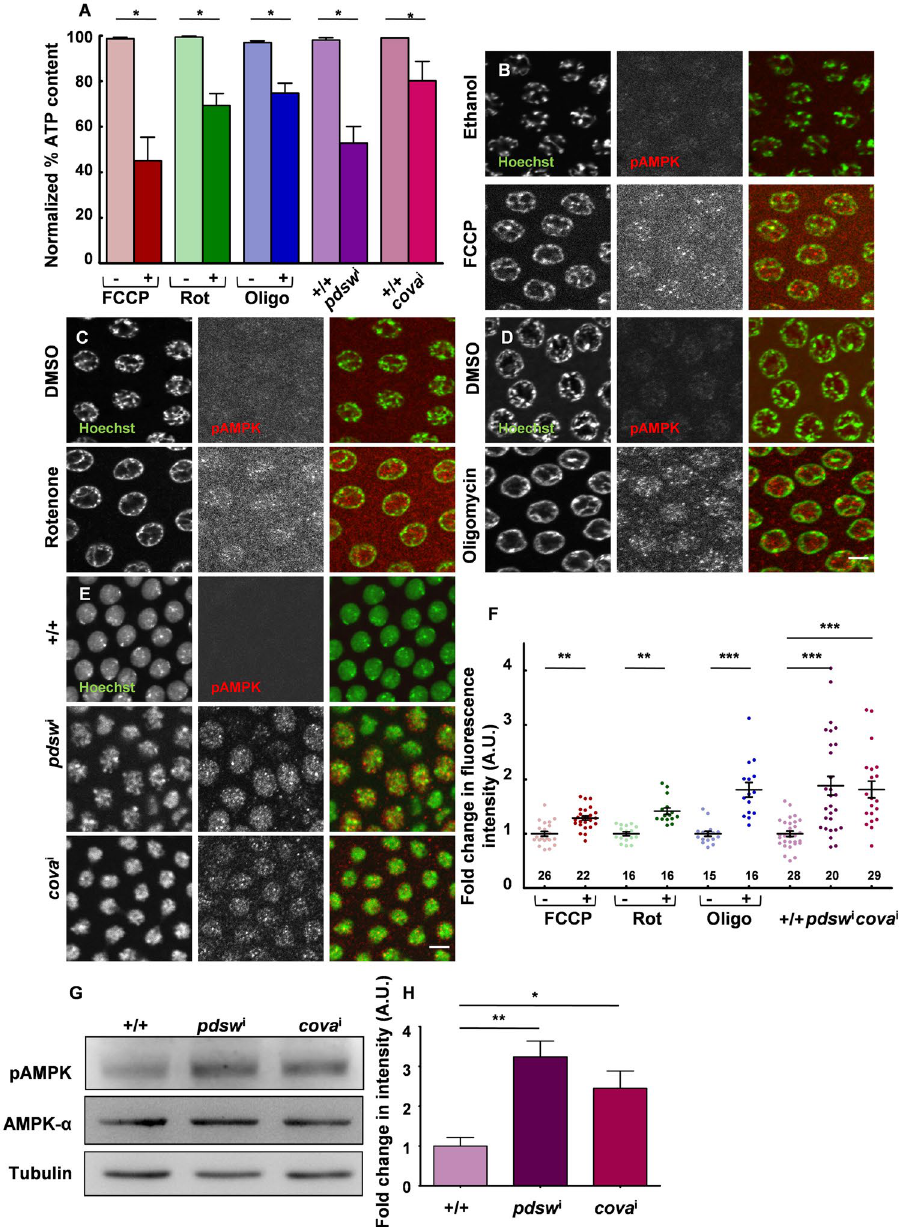
Figure 5. ETC depletion reduces ATP and increases pAMPK in syncytial Drosophila embryos. ( A ) Decrease in ATP due to ETC inhibition. The ATP concentration determined by a luciferase based assay is normalized to amount of protein from embryos in each sample and represented as a percentage of the corresponding control. FCCP (red), Rotenone (green) and Oligomycin (blue) treated embryos and pdsw i (purple) and cova i (pink) mutant embryos show a significant reduction in ATP. ( * P ≤ 0.05, n = 9, N = 3, one tailed Mann–Whitney test). ( B – F ) Genetic and pharmacological inhibition of the ETC shows increased pAMPK in syncytial embryos. Elevated pAMPK (red in merged) signal is seen in FCCP ( B ), Rotenone ( C ) and Oligomycin ( D ) treated embryos compared to respective controls imaged at the same settings. pdsw i and cova i ( E ) show increased pAMPK signal compared to control embryos. Normalized fluorescence intensity of pAMPK in embryos treated with FCCP (red), Rotenone (green) and Oligomycin (blue) and pdsw i (purple) and cova i (pink) compared to their respective controls represented by lighter shades ( F ). Numbers and data points represent embryos analysed. ( ** P ≤ 0.01; *** P ≤ 0.001, two tailed Mann-Whitney test.). n = 22, 26 embryos for control and FCCP; 16,16 embryos for control and Rotenone; 16, 15 embryos for control and Oligomycin; 29, 28 and 20 embryos for control, pdsw i and cova i respectively ( H ). On an average 21 syncytial cells per embryo were measured. N: FCCP-3, Rotenone and Oligomycin-4, pdsw i and cova i -3. Scale bar: 5 μ m. ( G – H ) Western blot of pAMPK and total AMPK in WT, pdsw i and cova i expressing embryos. Band intensity of pAMPK in normalized with total AMPK within each lane and represented as fold change with respect to WT ( H ). The full length blots are shown in Fig. S3F. Error bars represent SEM, N = 3, ( ** P ≤ 0.01; * P ≤ 0.05, Student’s t